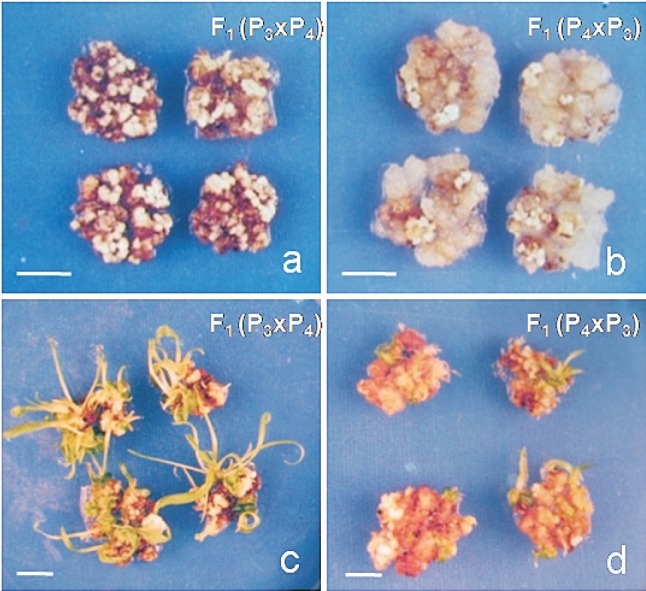
Differences in the quantities of embryogenic (A) and non-embryogenic (B) portions of callus and in the number of regenerated plantlets in the corresponding hybrid F1(P3xP4) (C) and reciprocal hybrid F1(P4xP3) (D) involving the P3 and P4 inbred lines. Scale bar =100 μm.